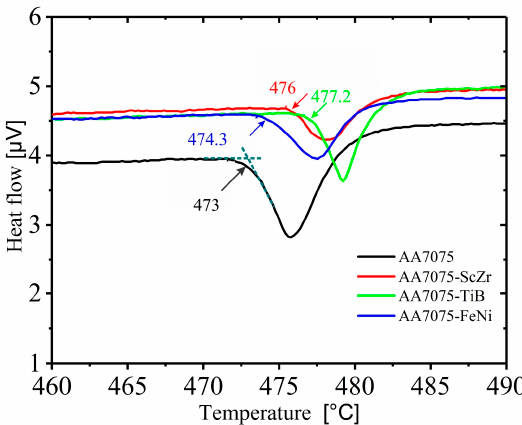
Figure 3. DSC analysis for the investigated alloys.